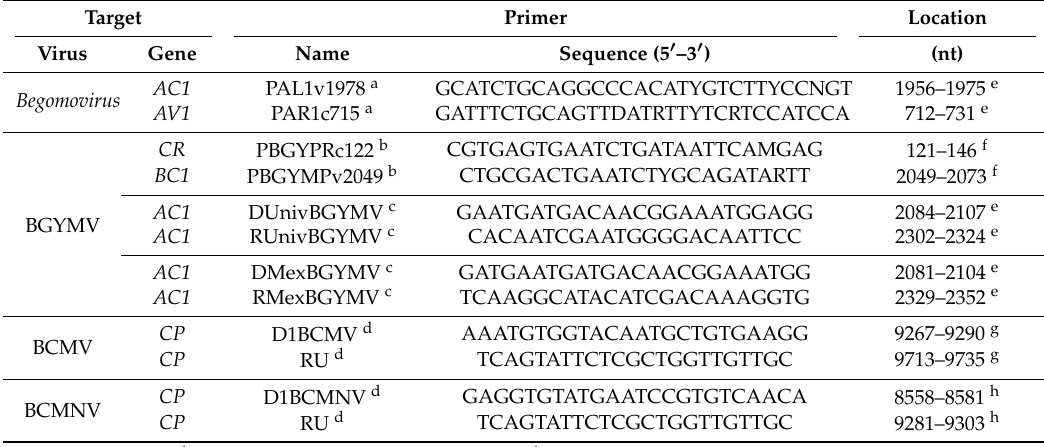
Table 1. Primers used in the optimization for uniplex, duplex and multiplex detection of bean common mosaic virus (BCMV), bean common mosaic necrotic virus (BCMNV), and bean golden yellow mosaic virus (BGYMV). Target